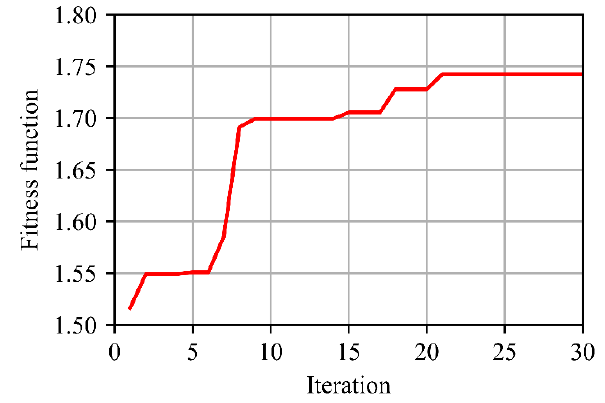
Figure 8. Change of the fitness function in the PSO optimization process.